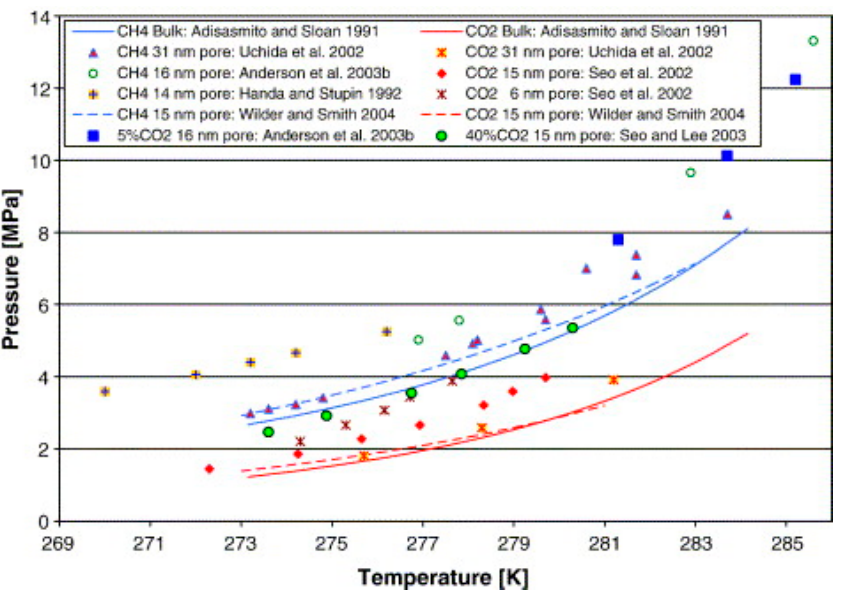
Figure 13. Equilibrium condition for methane and carbon dioxide hydrate in porous media and in bulk phase reprinted from [54] with permission from